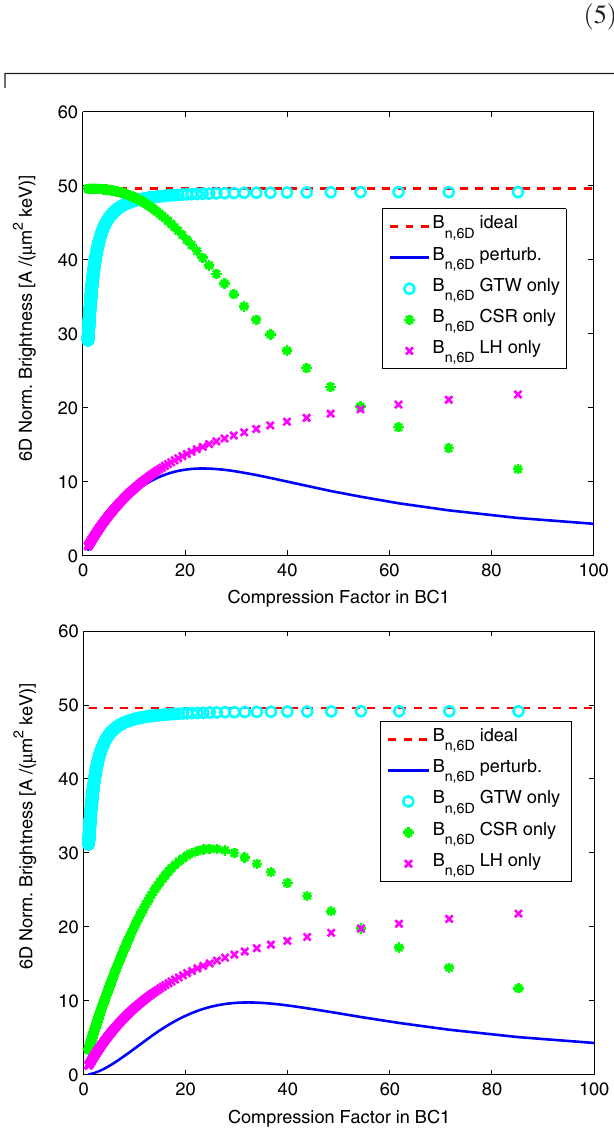
FIG. 7. Analytical estimate of B at the end of XL (see n; 6 D Fig. 3) for the one-stage (left) and two-stage compression, as a function of the compression factor in BC 1 . In the two-stage scheme, the total compression factor is fixed to